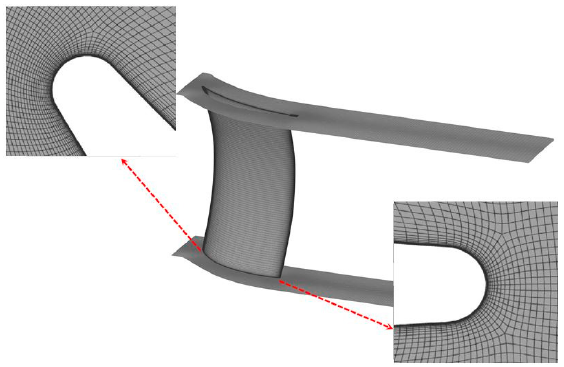
Figure 4. Grid distribution.